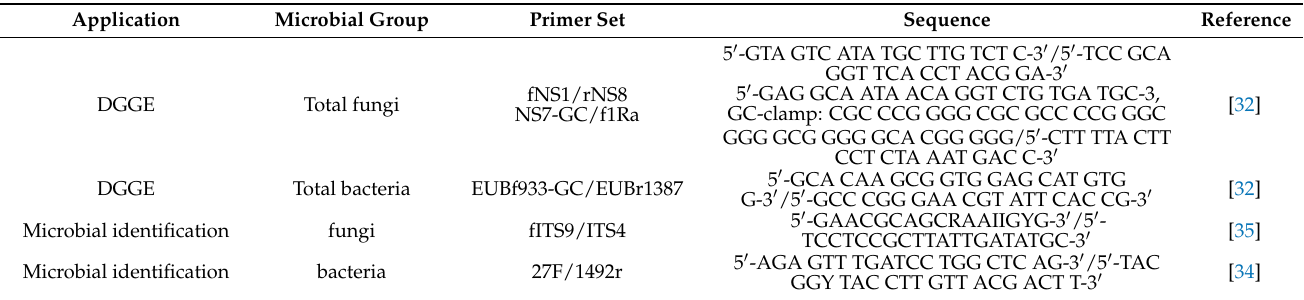
Table 1. Sequence of primers used in this